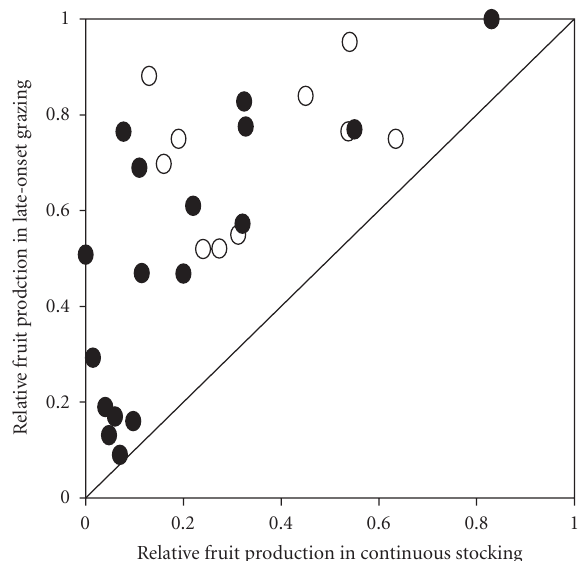
Figure 2: Mean per-species relative fruit production (proportion of inflorescences developing to mature fruit stage) of 27 plant species of grasses (open circles) and herbs/sedges (filled circles) in two grazing regimes, late onset of grazing (grazing from mid-July to early October), and continuous stocking (grazing from mid-May to early October), in a semi-natural grassland at Harpsund, see text for explanations.